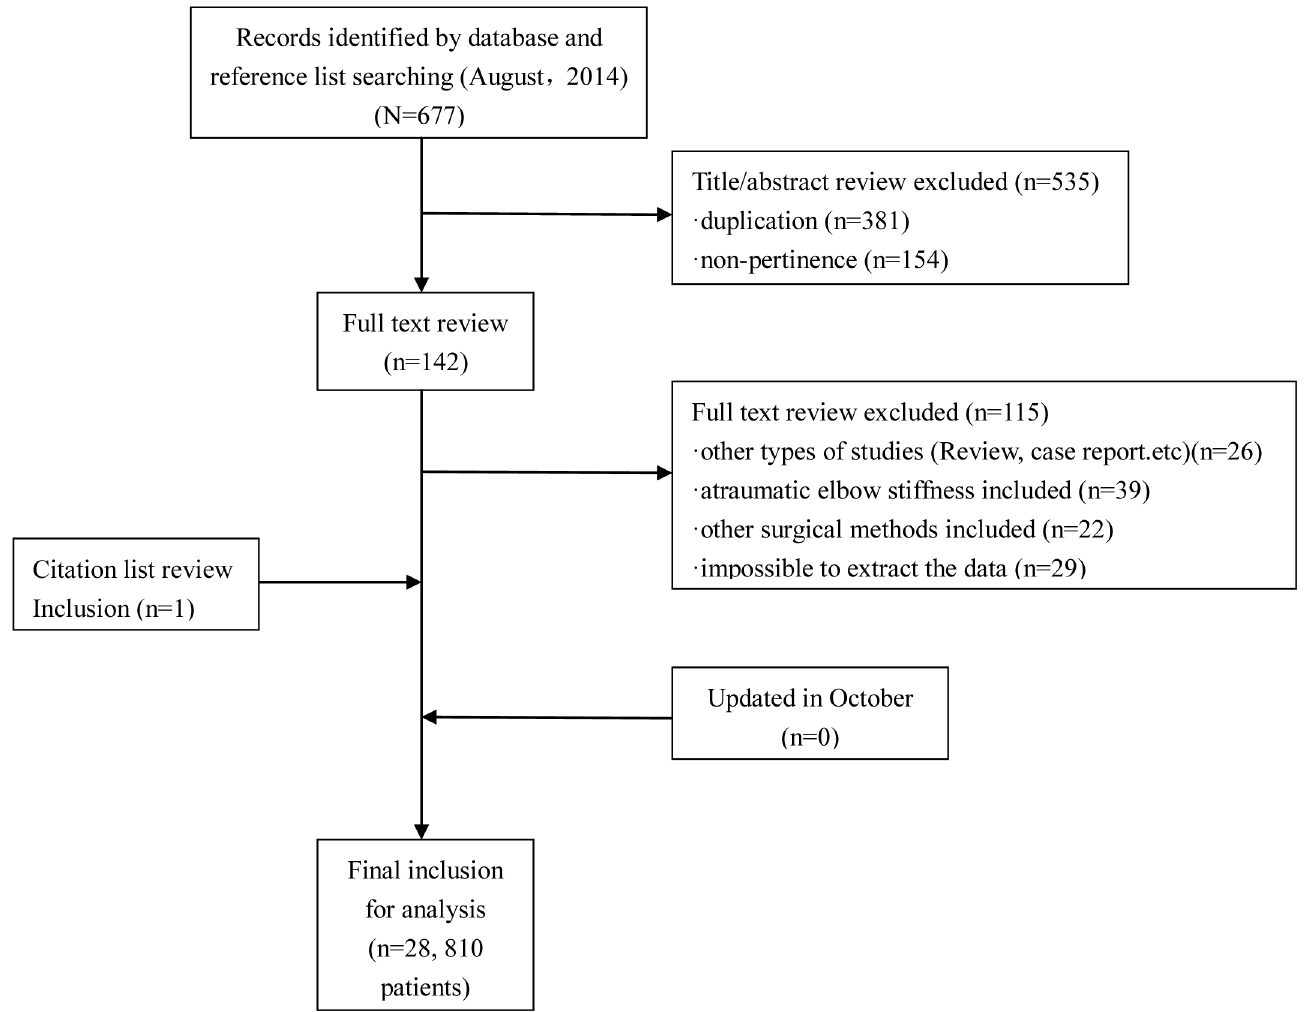
Fig 1. Flow diagram of study